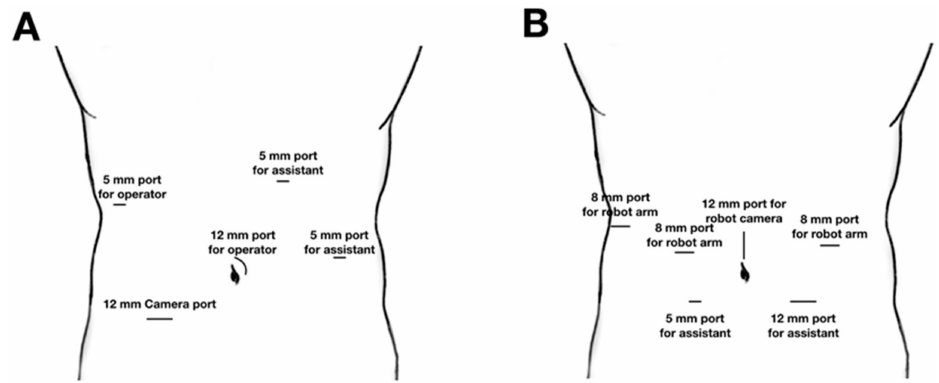
Figure 2. Trocar locations during MIPD. ( A ) Port locations for LPD and RPD performed during laparoscopic resection and anastomosis by robot instrument. ( B ) Port locations for RPD performed by robotic resection and